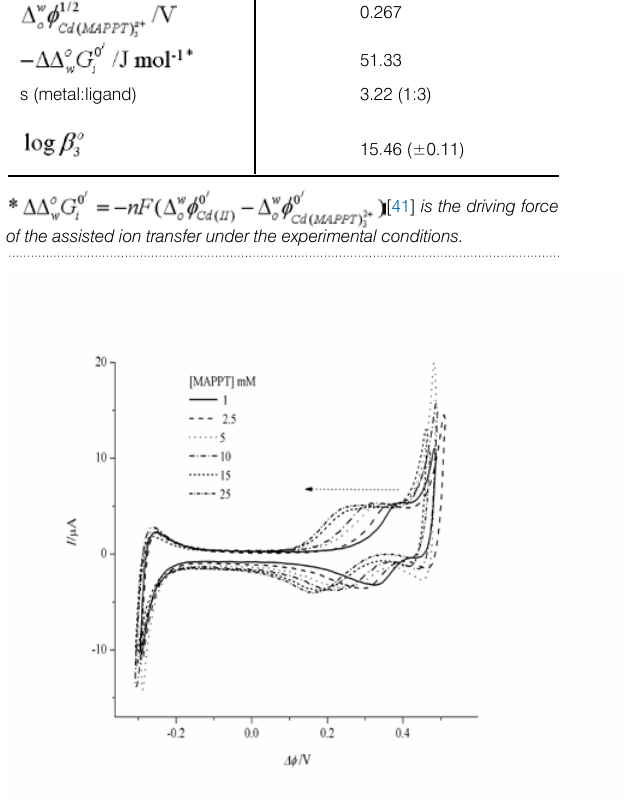
Figure 5. Evaluation of the influence of excess MAPPT concentration on Cd 2+ transfer (y=100 μM and v =50 mV s -1